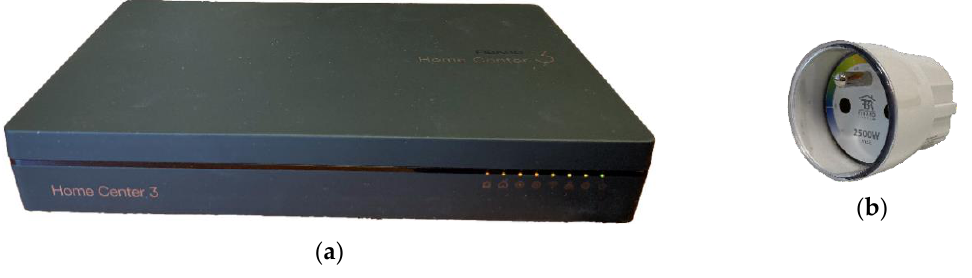
Figure 6. Fibaro system: ( a ) Gateway for Fibaro system management—Home Center 3; ( b ) Fibaro Wall Plug.